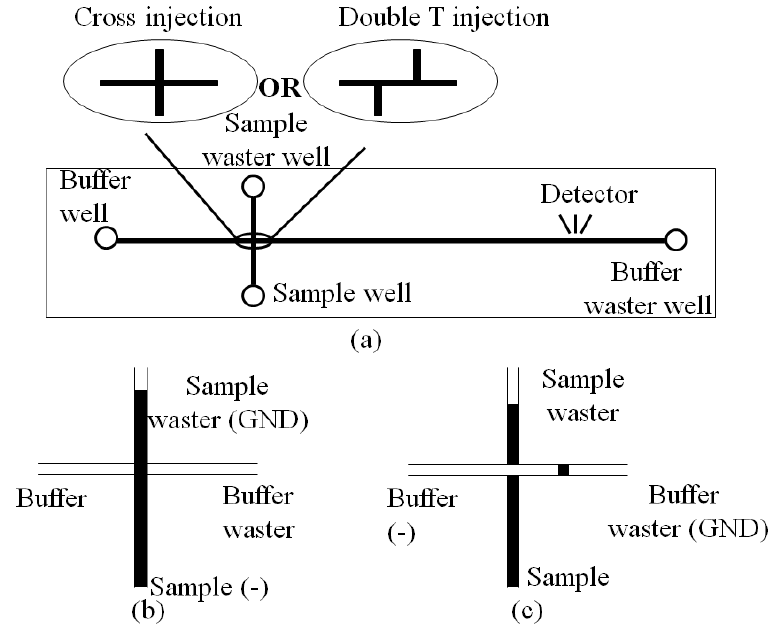
Figure 7. Schematic illustration of a CE chip: ( a ) a CE chip with reservoirs, ( b ) CE process of the injection phase, and ( c ) CE process of the separation phase.